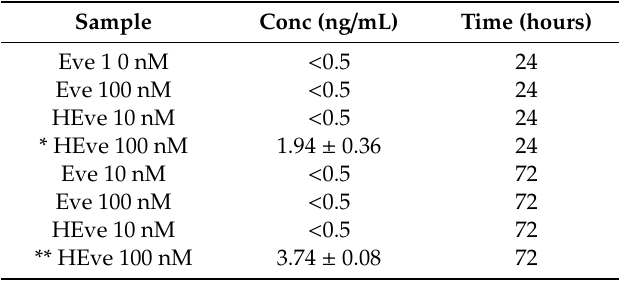
Table 2. Cytoplasmic extract. Reported values are the mean of three samples ± s.e.